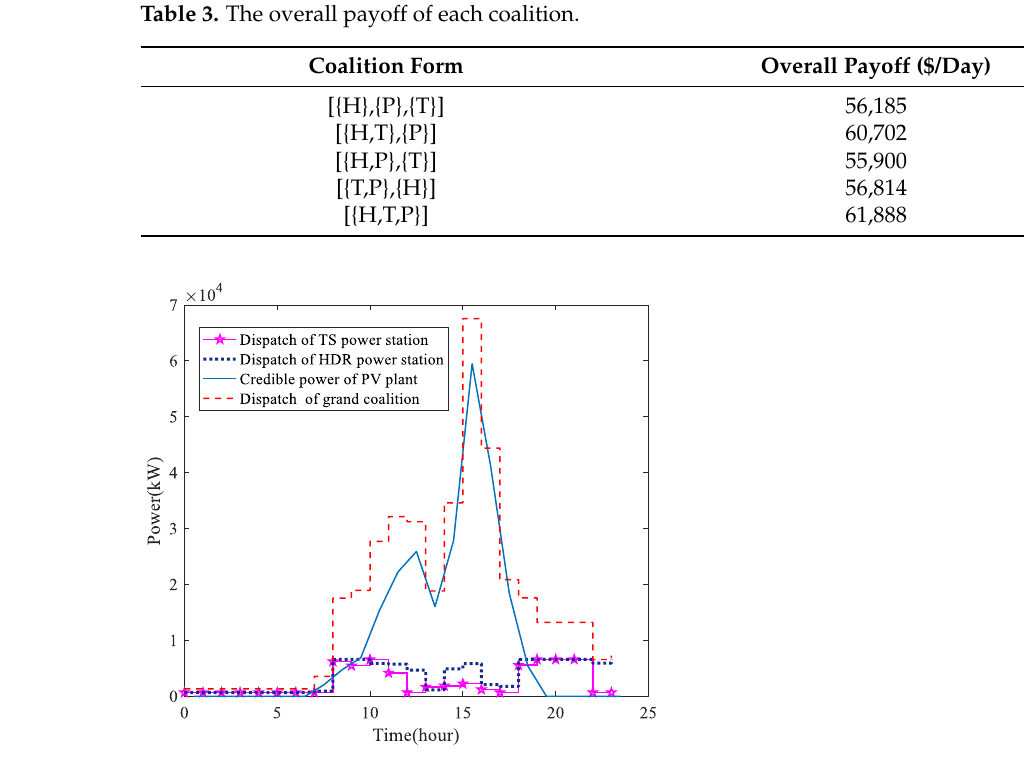
Figure 7. The coordinated dispatching of HDR - TS - PV coalition.